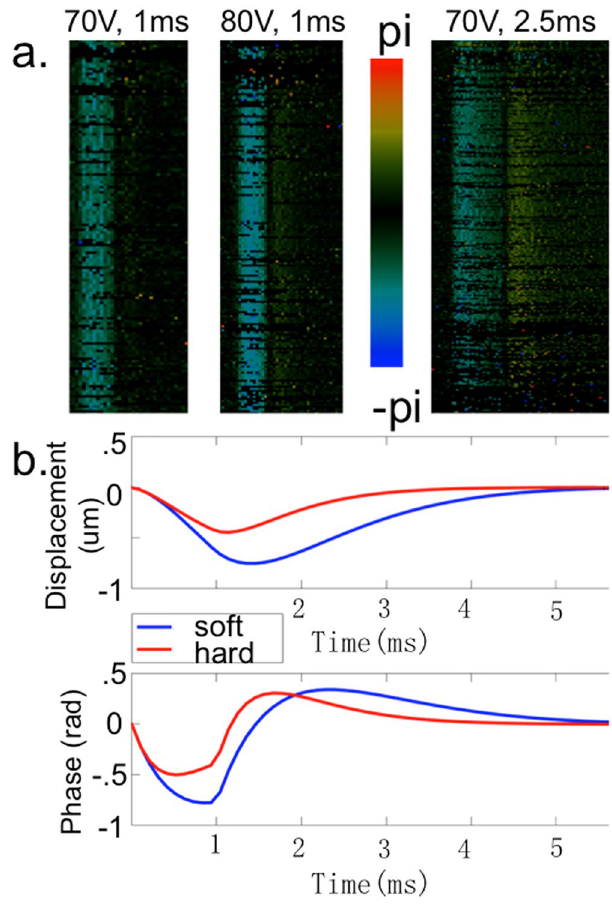
Figure 2. Displacement data. ( a ) Raw phase Doppler data of phantom response. ( b ) Displacement and phase analysis of response of 70 V, 1ms